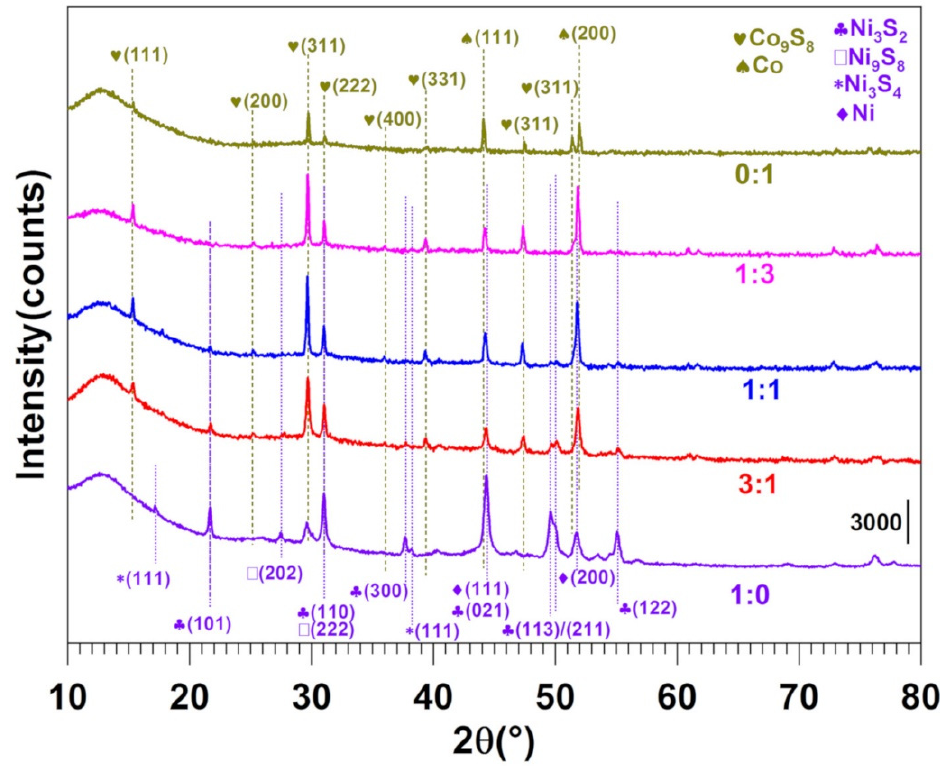
Figure 2. XRD patterns for electrocatalysts obtained for PANI-Ni:PANI-Co ratios of 1:0, 3:1, 1:1, 1:3, and 0:1 based on atomic ratio of Ni:Co after calcination.